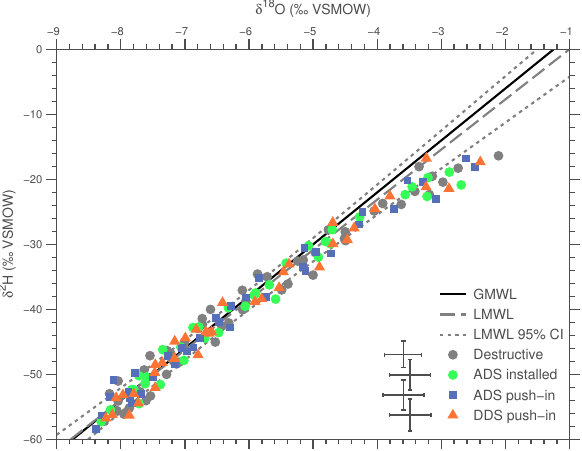
Figure 5. Plot of pore water δ 2 H l versus δ 18 O l obtained based on in situ and destructive sampling of soil profiles (depths from 10 to 60cm). The methodological accuracy associated with each symbol is indicated in terms of 95% limits of